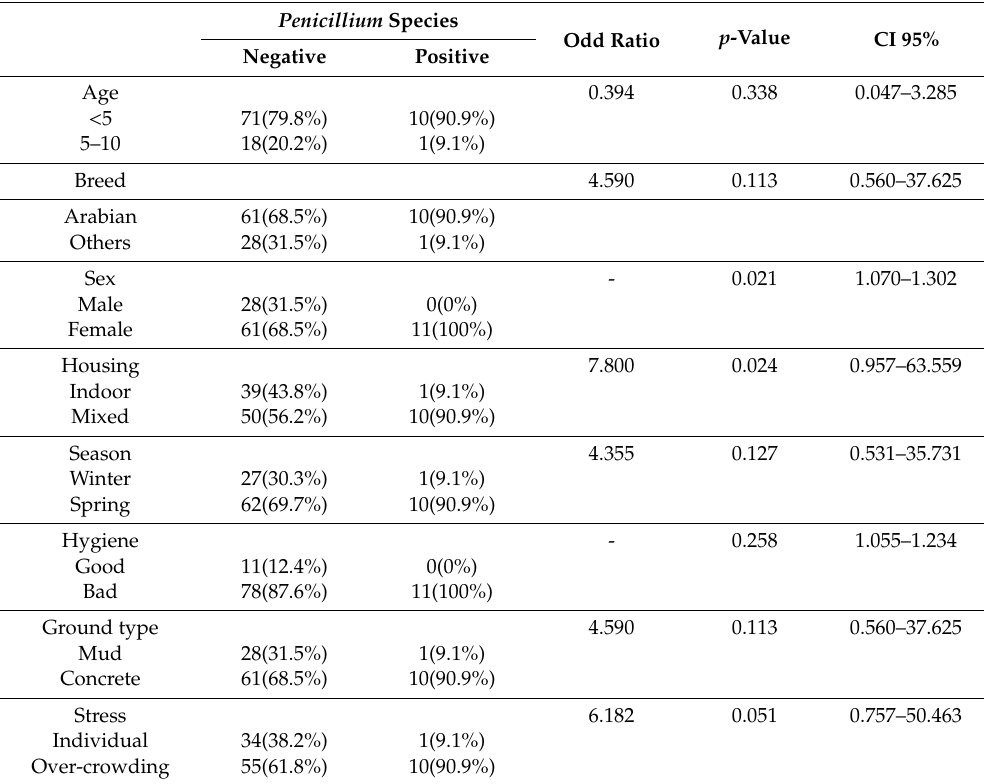
Table 7. Risk factors of Penicillium